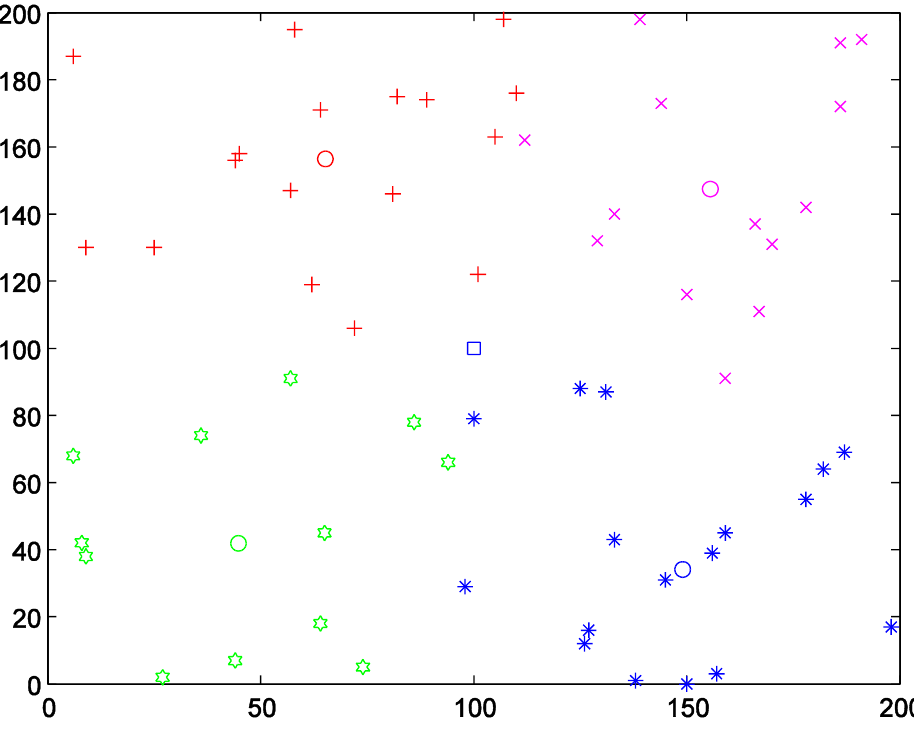
Figure 4. The selected TDCs and assigned MAPs with four TDCs.